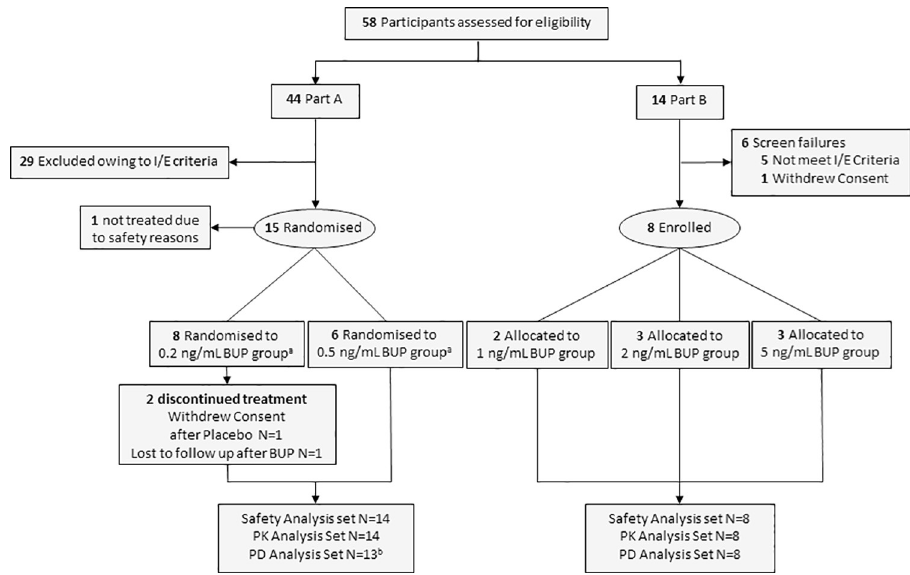
Fig 1. CONSORT flow diagram. BUP, buprenorphine; PD, pharmacodynamic; PK, pharmacokinetic. a Randomised sequences for Part A were Placebo:BUP N = 5, BUP:Placebo N = 3 for the 0.2 ng/mL group and Placebo:BUP N = 2, BUP:Placebo N = 4 for the 0.5 ng/mL group. b One volunteer in the lower dose group received the incorrect buprenorphine dose and was excluded from the PD analyses. Data were available for six healthy volunteers in each treatment (placebo and buprenorphine) for the PD analyses in the lower dose group due to two volunteers in the lower dose group who completed only one study period.